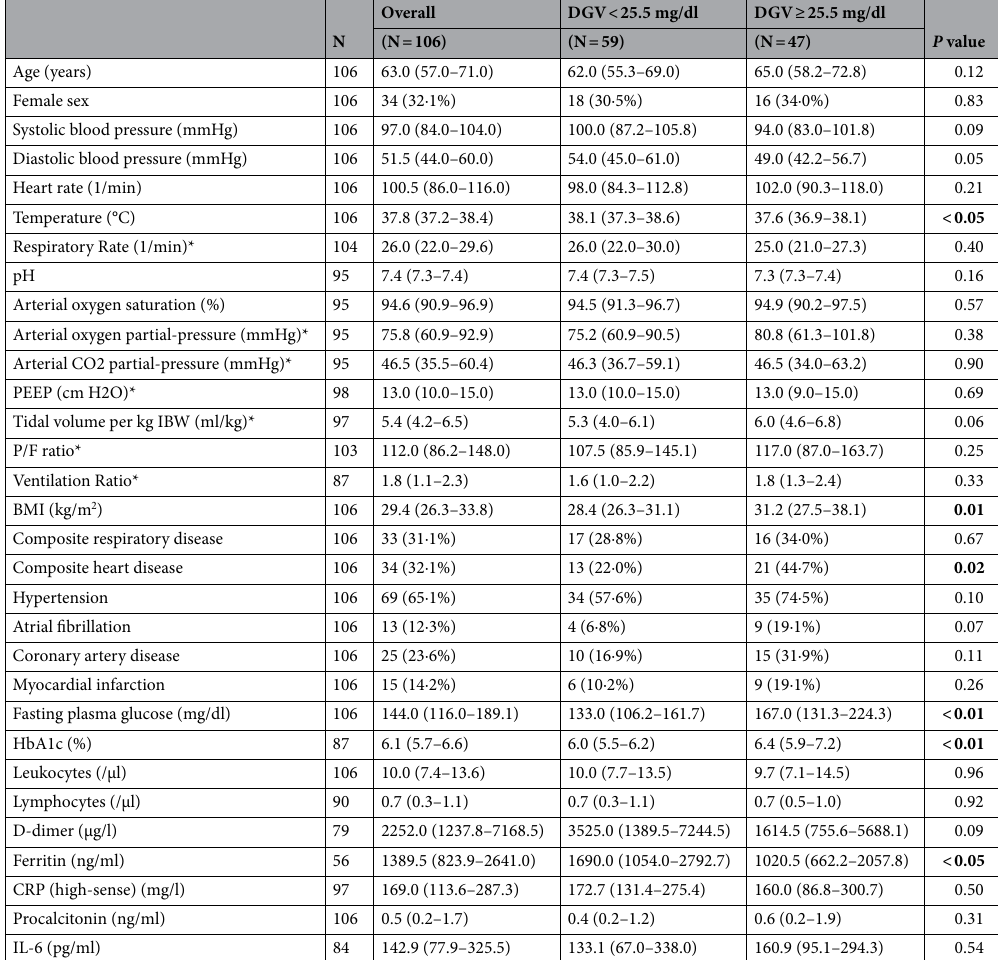
Table 1. Characteristics of patients admitted with COVID-19 and ARDS to the Intensive Care Unit. Numerical parameters are expressed as median (IQR) and categorical as N (%). The N column represents the number of non-missing values in each row to the right. P -values for differences between the two groups were tested using Fisher’s exact test for categorical variables and Kruskal–Wallis test for continuous variables. Bold indicates significant differences ( P < 0.05). Parameters denoted with * represent the worst value on the day of admission. Composite heart disease is defined as atrial fibrillation, coronary artery disease, hypertension, heart failure or history of myocardial infarction. Composite respiratory disease was defined as a composite of bronchial asthma, chronic obstructive pulmonary disease, obstructive sleep apnoea syndrome and pulmonary